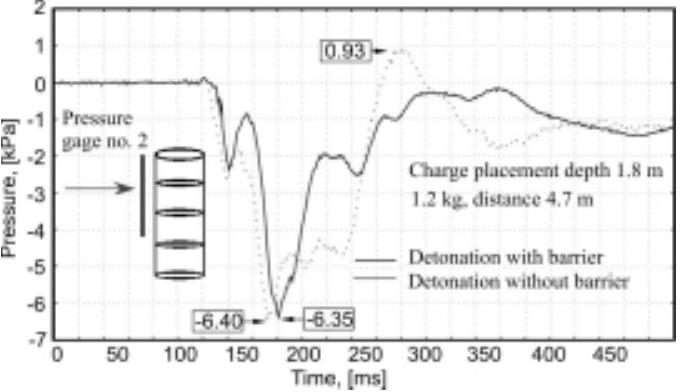
Fig. 16. Time histories of pressures p h on the structure front, measured by gage No. 2, from a detonation at 4.7 m from the silo. 4.78 kPa. Similarly, the pressures registered by the gage No. 5 placed at the same depth ( z/D = 1.01) on the side of the silo were 2.71 kPa and 2.90 kPa for the attenuated and unattenuated cases, respectively. Comparatively, the high pressure attenuation ( C t = 0.36) was stated on level z = 2.65 m of gage No. 8 (Fig.